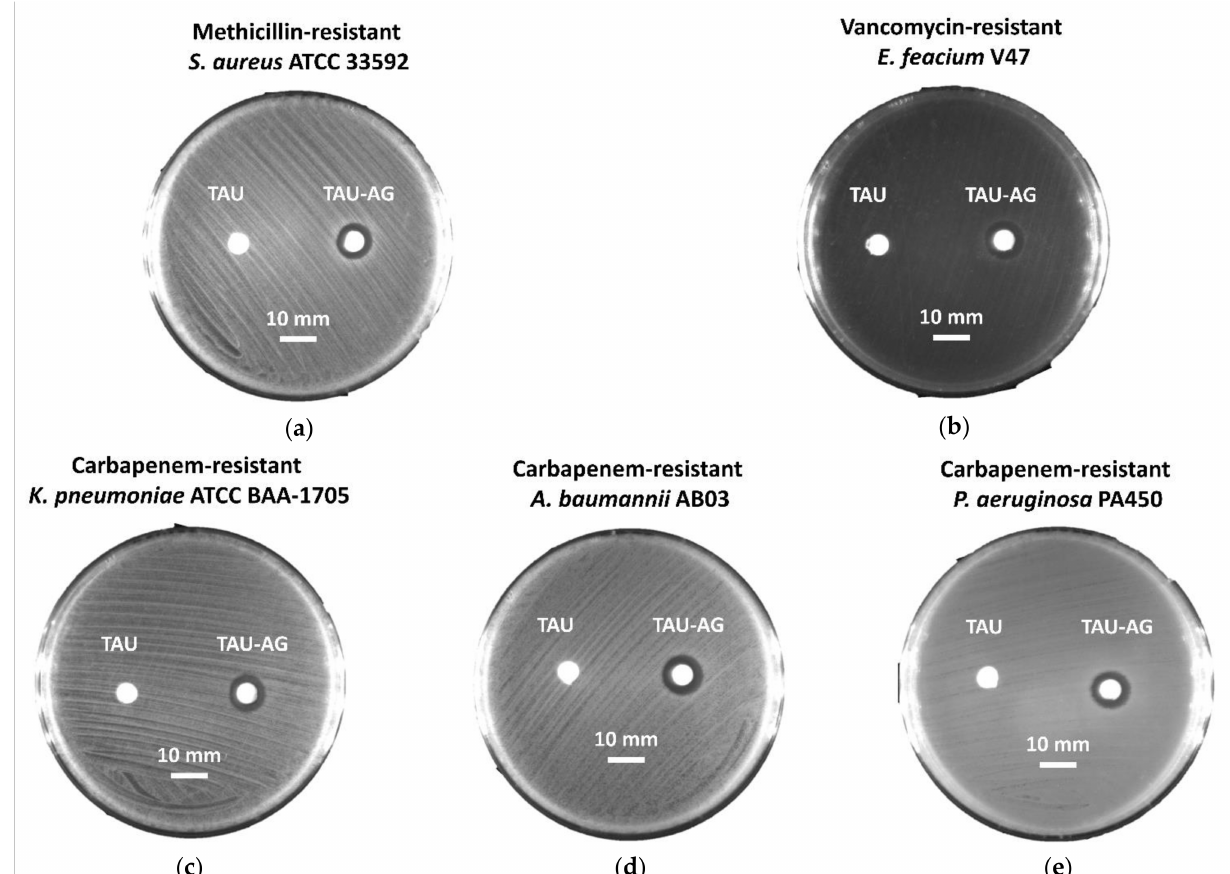
Figure 8. Disk diffusion analysis for ( a ) methicillin-resistant S. aureus (MRSA) ATCC 33592, ( b ) vancomycin-resistant E. feacium (VRE) clinical isolate V47, ( c ) carbapenem-resistant K. pneumoniae (CRKP) ATCC BAA-1705, ( d ) carbapenem-resistant A. baumannii (CRAB) clinical isolate AB03, and ( e ) carbapenem-resistant P. aeruginosa (CRPA) clinical isolate PA450. The scale represents a 10 mm length. The Tau disks contain 10 µ L of 2% taurine solution each as a control, while the disks of Tau-Ag were dipped in 10 µ L of taurine-induced silver ions (20